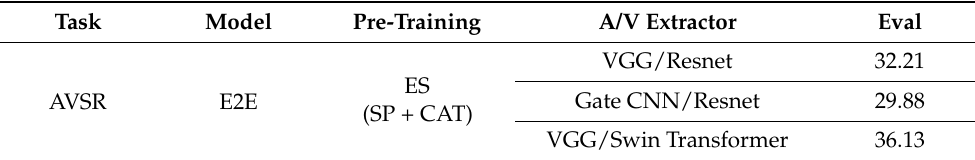
Table 4. The results (CER %) of the different model architectures. ES means the end-to-end system. SP means speed perturbation. CAT means splicing the continuous segments.